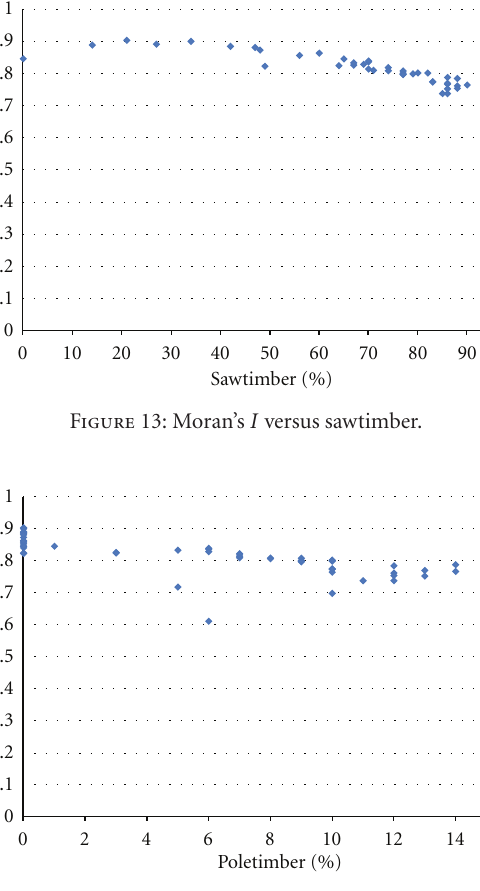
Figure 14: Moran’s I versus poletimber.